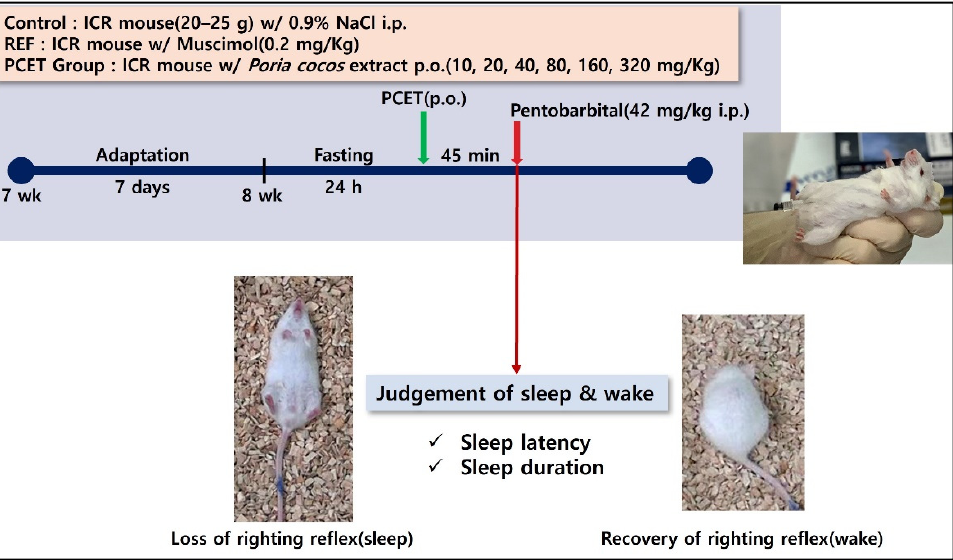
Figure 1. Pentobarbital-induced sleep test concept diagram. Measurement of sleep latency and sleep duration according to PCET oral intake concentration in sleep-induced mice using different intraperitoneal pentobarbital injections.